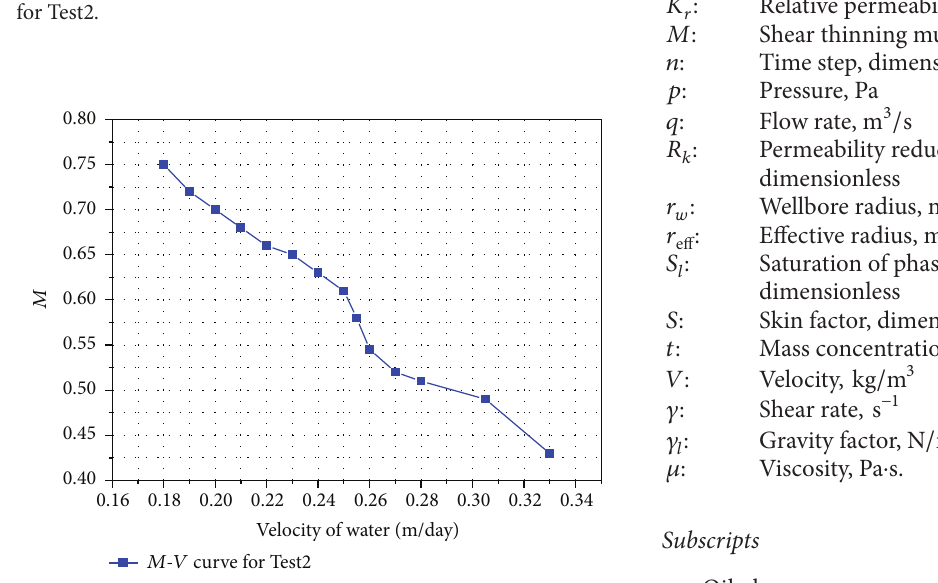
Figure 14: Pressure change and pressure derivative history match for Test2.